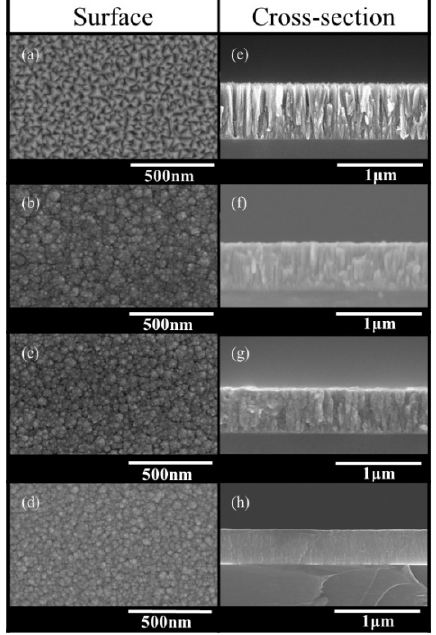
Figure 3. Microstructure through FE-SEM for the MoN coating surface (( a ) ICP 0 W, ( b ) ICP 50 W, ( c ) ICP 100 W, ( d ) ICP 200 W), and cross-sectional FE-SEM, (( e ) ICP 0 W, ( f ) ICP 50 W, ( g ) ICP 100 W, ( h ) ICP 200 W).